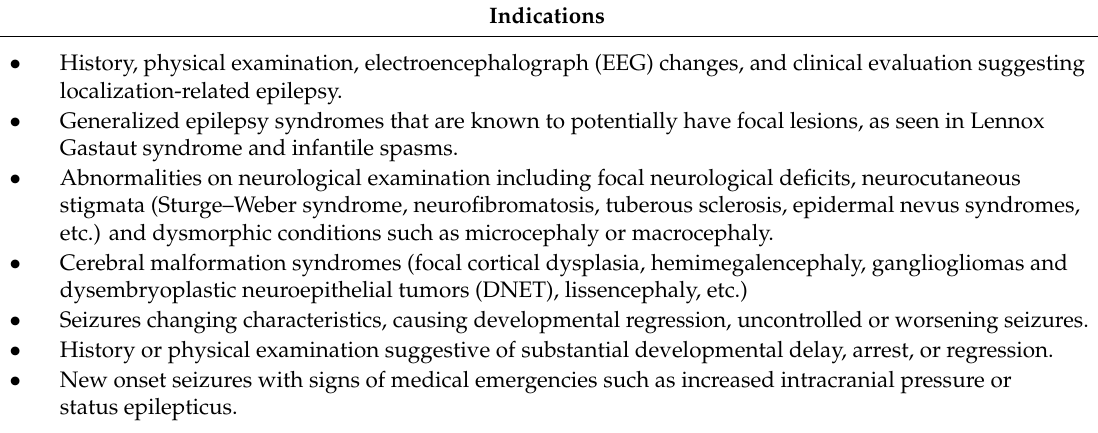
Table 1. Indications for structural neuroimaging in pediatric